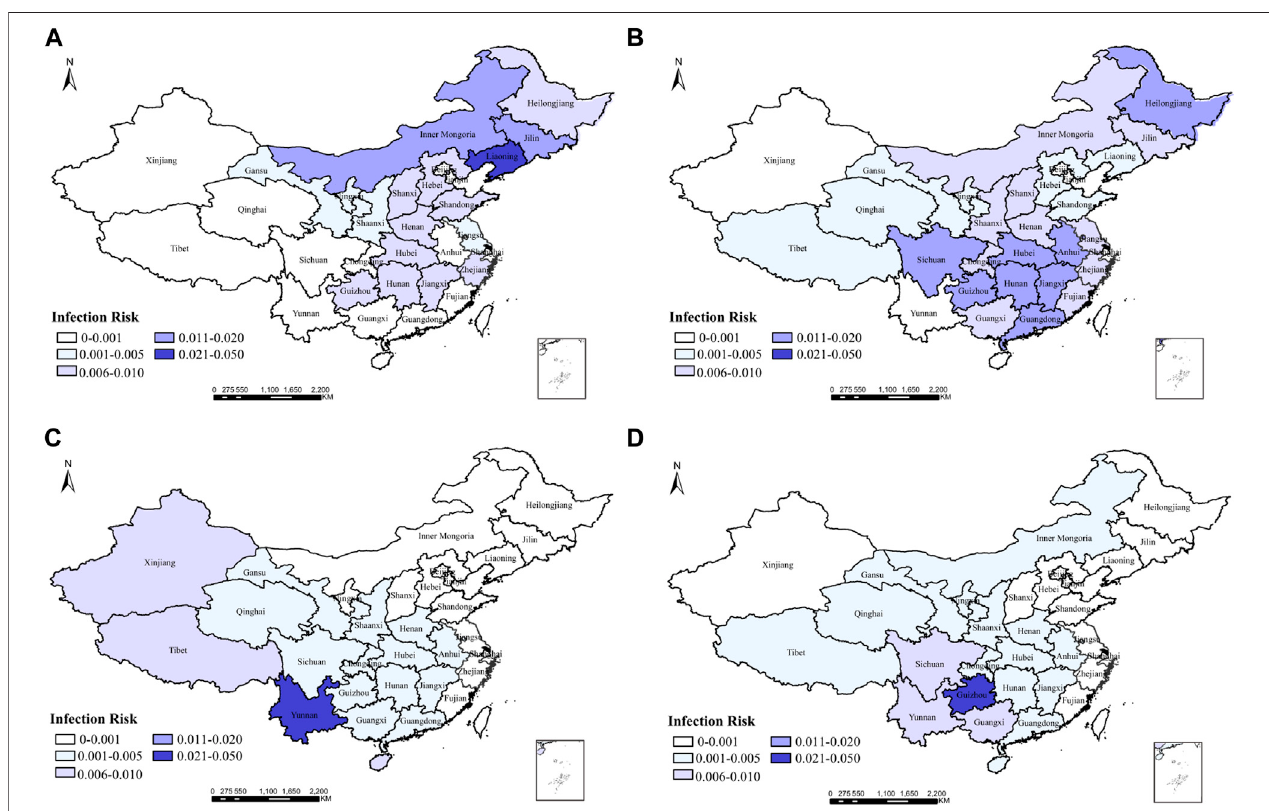
FIGURE 10 | Infection risk maps of ASFV in mainland China in (A) October 2018, (B) December 2018, (C) April 2019, and (D) June 2019.